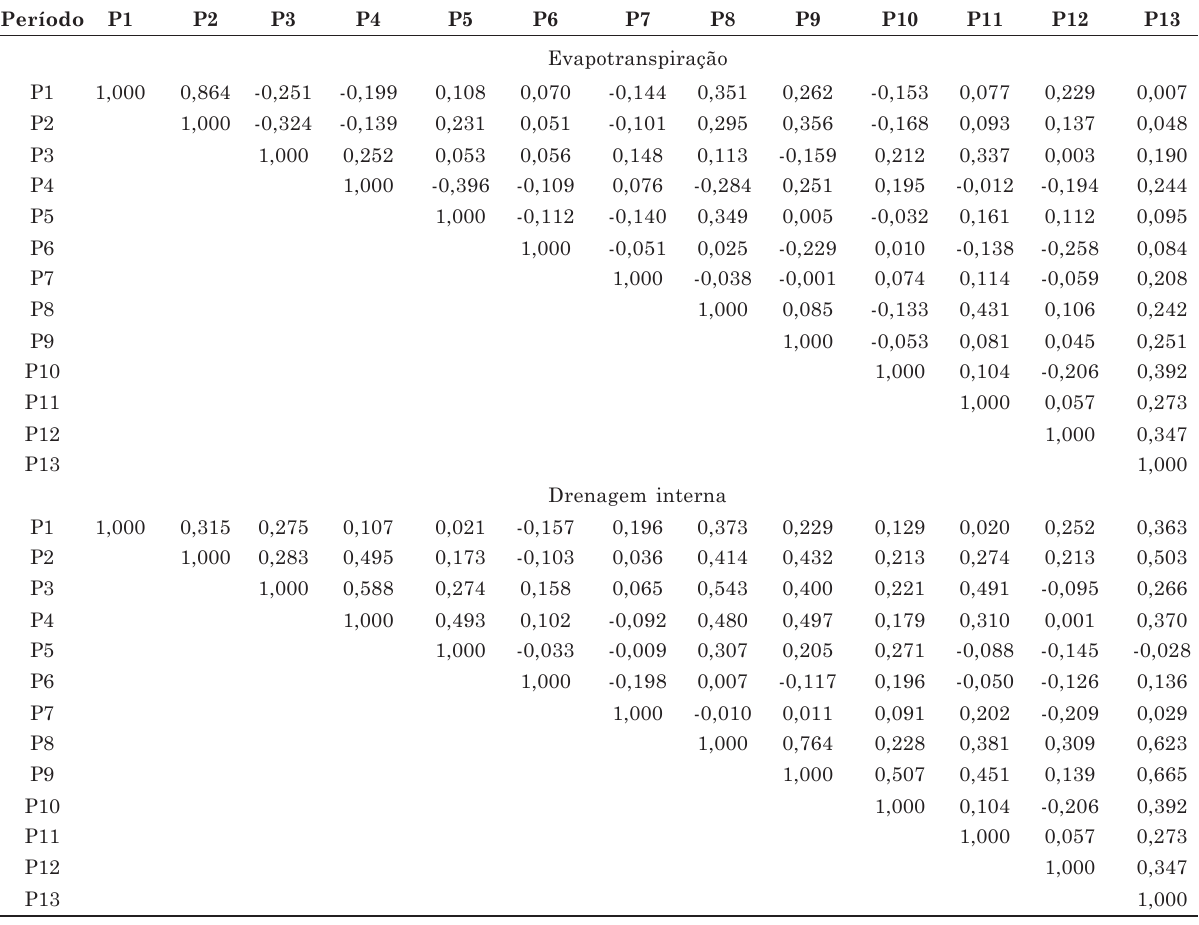
Quadro 4. Coeficiente de correlação de Spearman entre os valores de evapotranspiração e de drenagem interna no solo nos 13 períodos. Valores acima de 0,40 foram significativos a